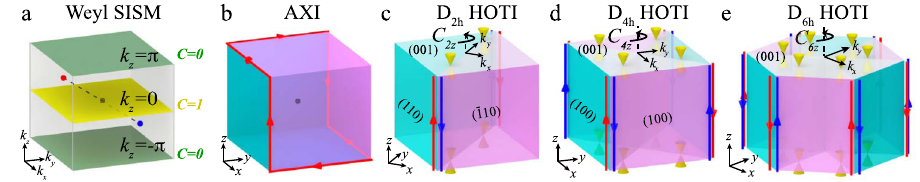
Fig. 5 The fi ve families of 3D symmetry-indicated, spinful, strong topological phases. In this work, we have computed the complete set of symmetry- indicated spinful topological phases of 3D magnetic and nonmagnetic crystalline solids (see SN 26). We fi nd that, for spinful bands in 3D crystals that satisfy the insulating the compatibility relations along all high-symmetry lines and planes [see SN 16], there are only fi ve families of symmetry-indicated strong topological phases: ( a ) Smith-index Weyl SMs (Weyl SISMs), ( b ) axion insulators (AXIs) and 3D TIs de fi ned by the nontrivial axion angle 19 – 21,55,63 θ = π [e.g., MnBi 41,42 ], ( c ) helical TCIs and higher-order TCIs (HOTIs) equivalent to two superposed AXIs with the same orbital hybridization and 2 Te 4 twofold rotation or rotoinversion symmetry [e.g., bismuth 33 and MoTe 2 34 ], ( d ) helical TCIs and HOTIs equivalent to four superposed AXIs with the same orbital hybridization 54 and fourfold rotation or screw symmetry [e.g. SnTe 24,28 ], and ( e ) helical TCIs and HOTIs equivalent to six superposed AXIs with the same orbital hybridization and sixfold rotation or screw symmetry. Through the double SIs calculated for this work (Table 2 and SN 31 and 32), we have discovered the existence of helical magnetic HOTIs with mirror-protected hinge states and bulk topology respectively enforced by the mirror and rotation symmetries of ( c ) double MPG 8.1.24 mmm [i.e., D 2 h , see ref. 11 ], ( d ) double MPG 15.1.53 4/ mmm [ D 4 h ], and ( e ) double MPG 27.1.100 6/ mmm [ D 6 h